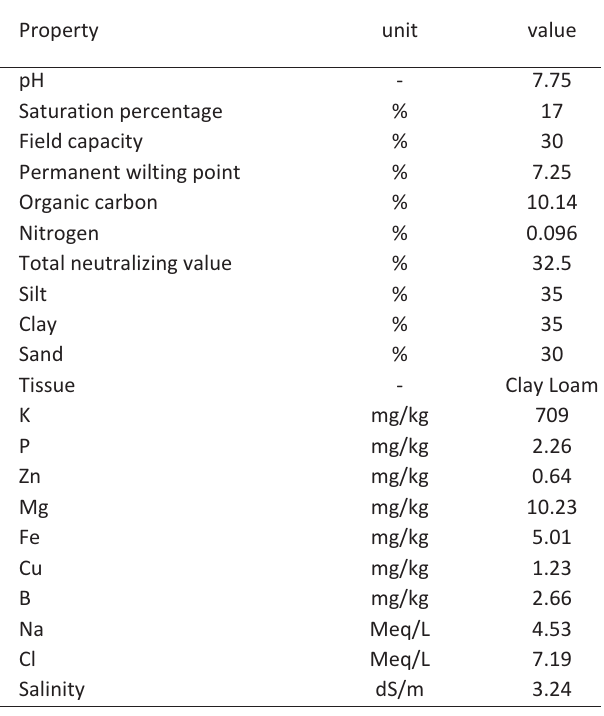
Table 1 ­ Some physical and chemical properties of soil mixture